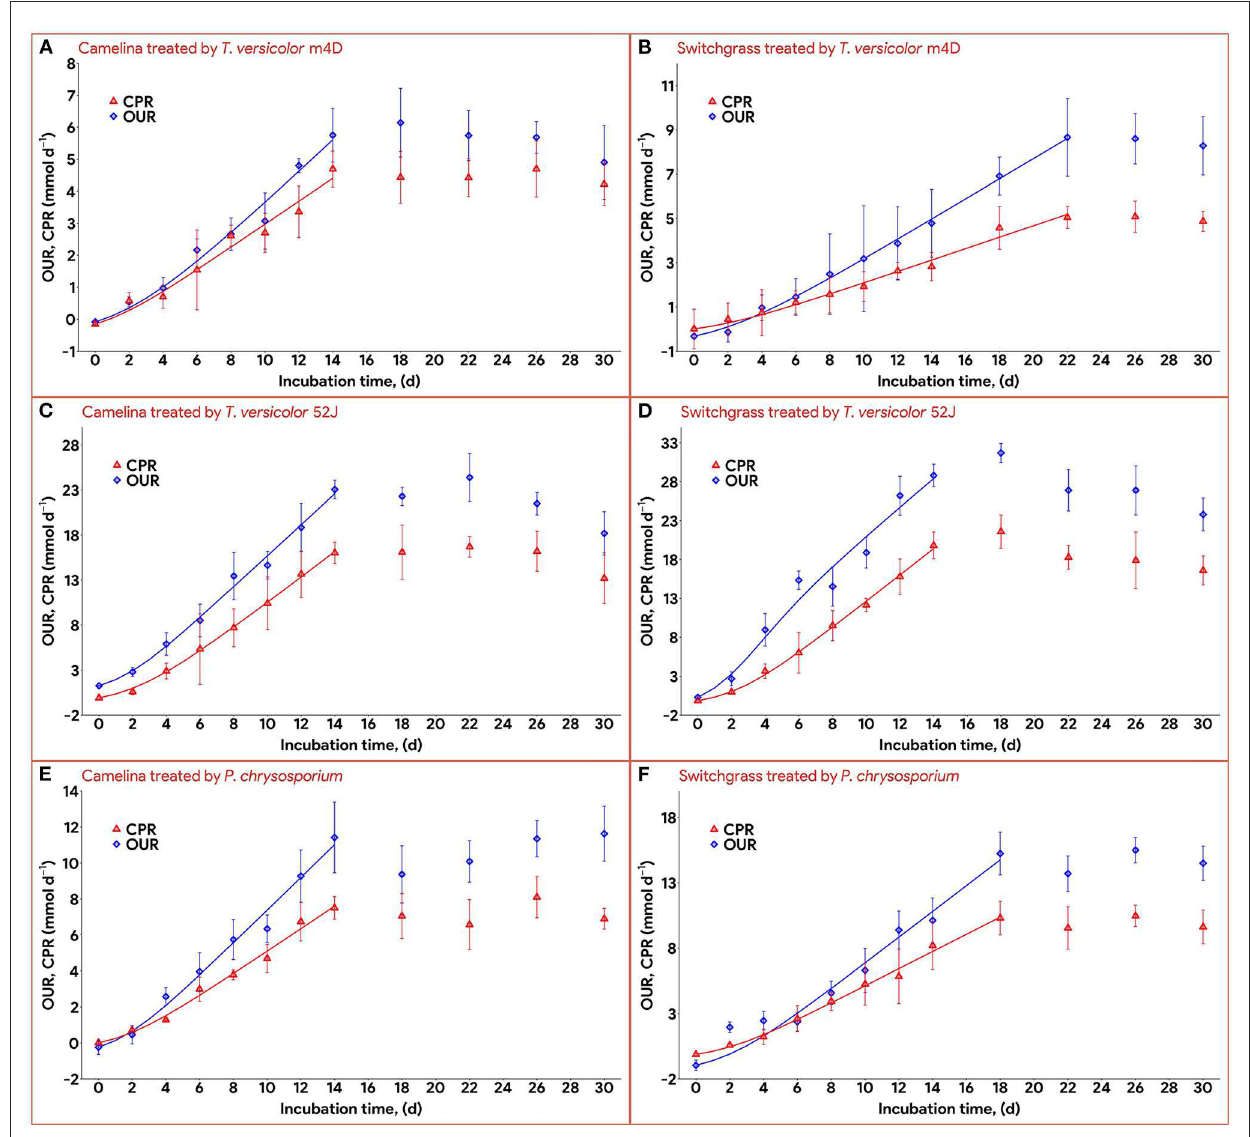
FIGURE6 Time profiles of oxygen uptake rate and carbon dioxide production rate during 30 d of microbial pretreatment: (A) : profiles of TVm4D on CS, (B) : profiles of TVm4D on SG, (C) : profiles of TV52J on CS, (D) : profiles of TV52J on SG, (E) : profiles of PC on CS, (F) : profiles of PC on SG. OUR, oxygen uptake rate; CPR, carbon dioxide production